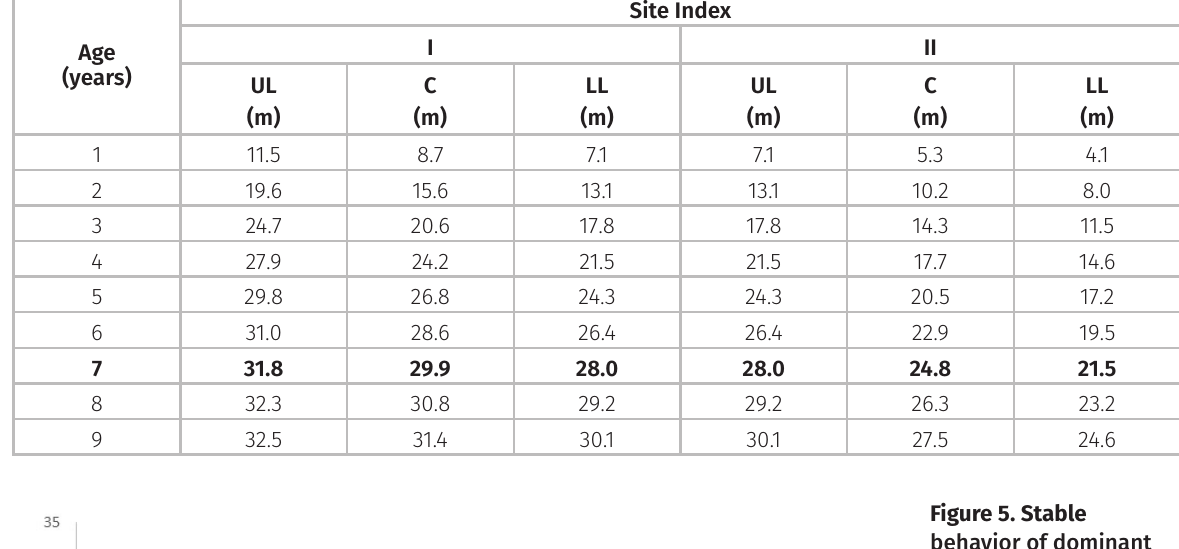
Figure 5. Stable behavior of dominant heights in the same site index for Eucalyptus sp.